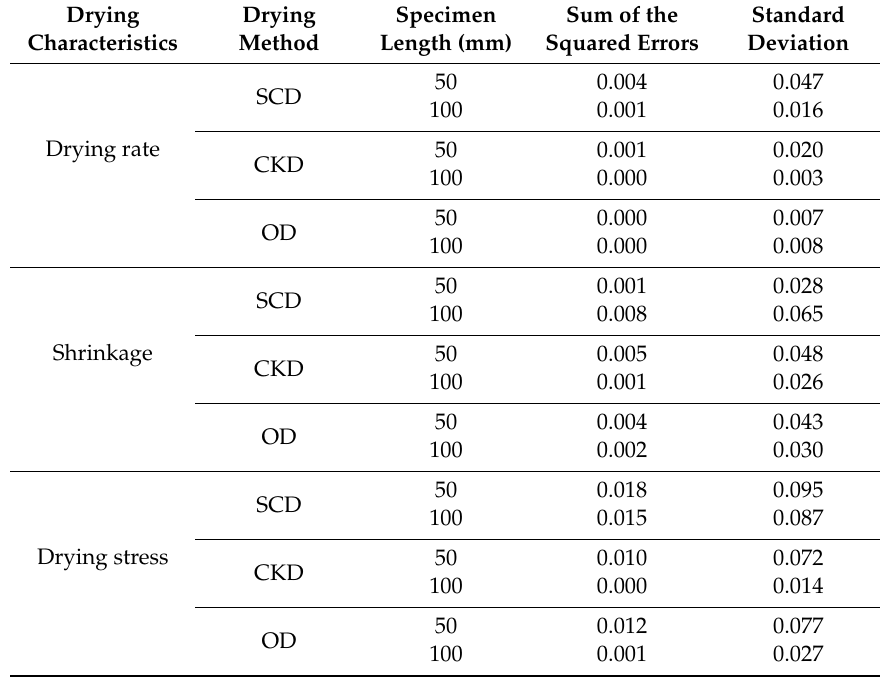
Table 8. Error analysis data for drying characteristics with drying methods and specimen lengths.